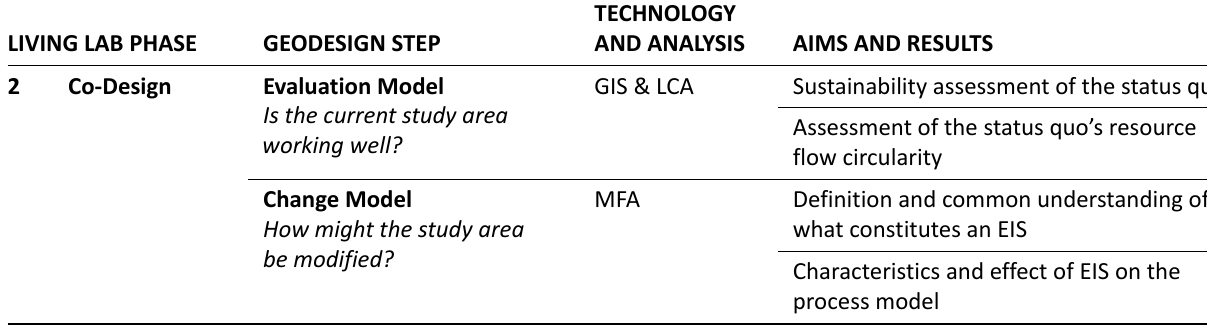
Table 3. Addressing geodesign questions at PULL phase